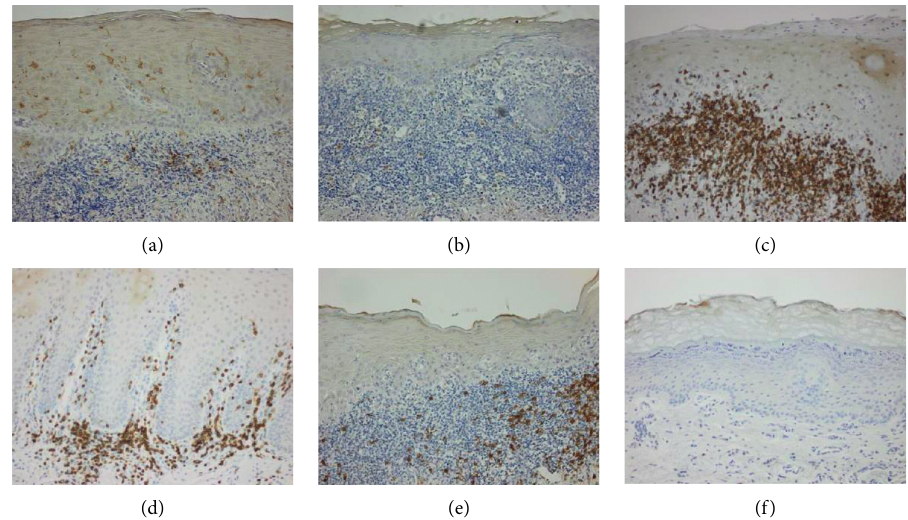
Figure 3: Light micrographs of: CD1a + cells in (a) oral lichen planus (OLP) and (b) oral leukoplakia (LPL); CD3 + cells in (c) OLP and (d) LPL; CD20 + cells in (e) OLP and (f) LPL. Positive cells are stained brown. Magnification ×